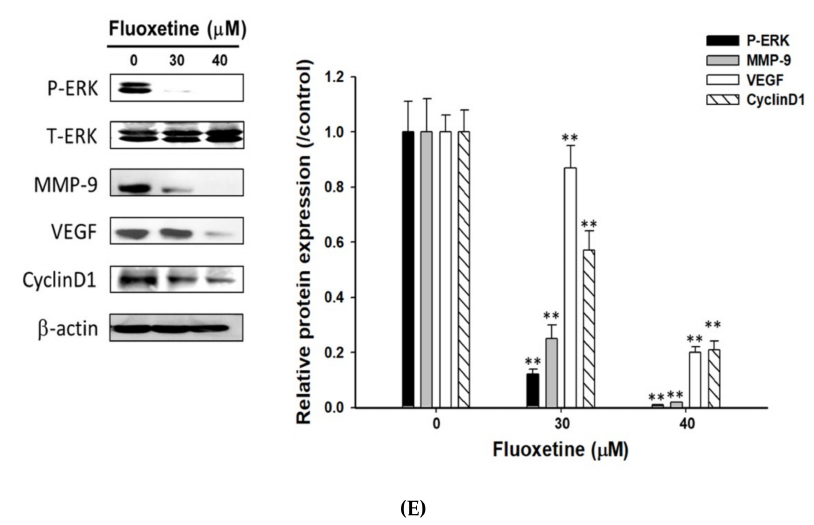
Figure 4. Fluoxetine decreased the cell migration/invasion and expression of pERK, metastasis- associated and proliferative proteins in SK-Hep1 and Hep3B cells. SK-Hep1 and Hep3B cells were treated with 0, 30 µ M, and 40 µ M of fluoxetine for 48 h. Then ( A , C ) migration assay or ( B , D ) invasion assay was performed. Quantification results were measured by four selected field per group. ( E ) Western blots were performed with P-ERK, T-ERK, MMP-9, VEGF and CyclinD1 antibodies to the indicated protein expression after fluoxetine treatment on SK-Hep1 cells. Quantification data were normalized by β -actin expression and averaged over three repeated experiments. ** p < 0.01, significant difference between control and fluoxetine-treated groups.